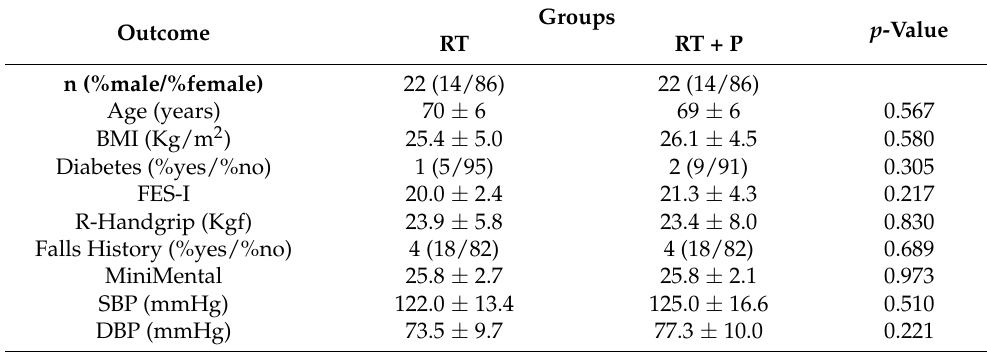
Table 1. Participants’